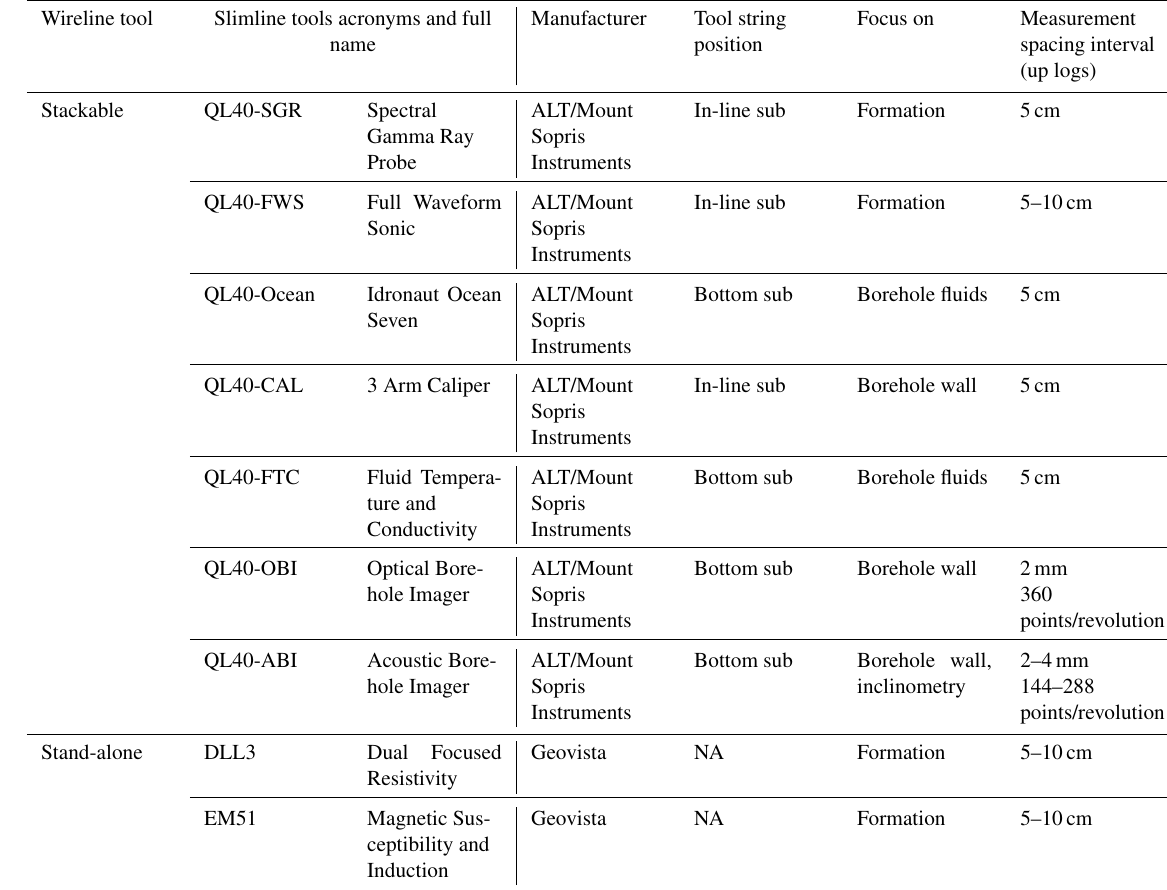
Table 1. Summary of wireline slimline probes; Expedition 364. Modified from Morgan et al. (2017). Wireline